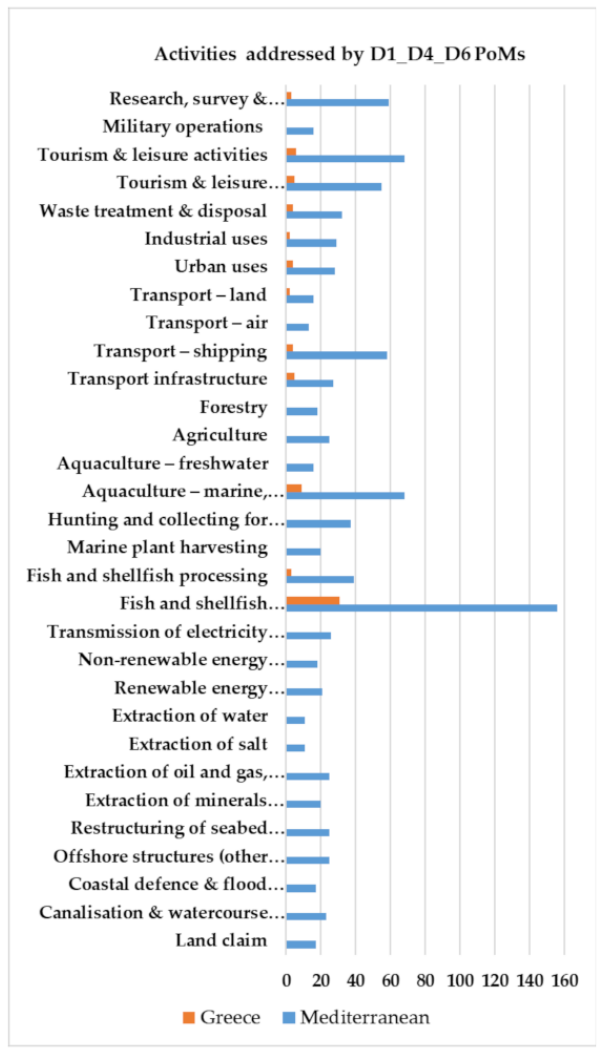
Figure 15. Established measures under Biodiversity Descriptors addressing activities generating pressures for Greece and Mediterranean